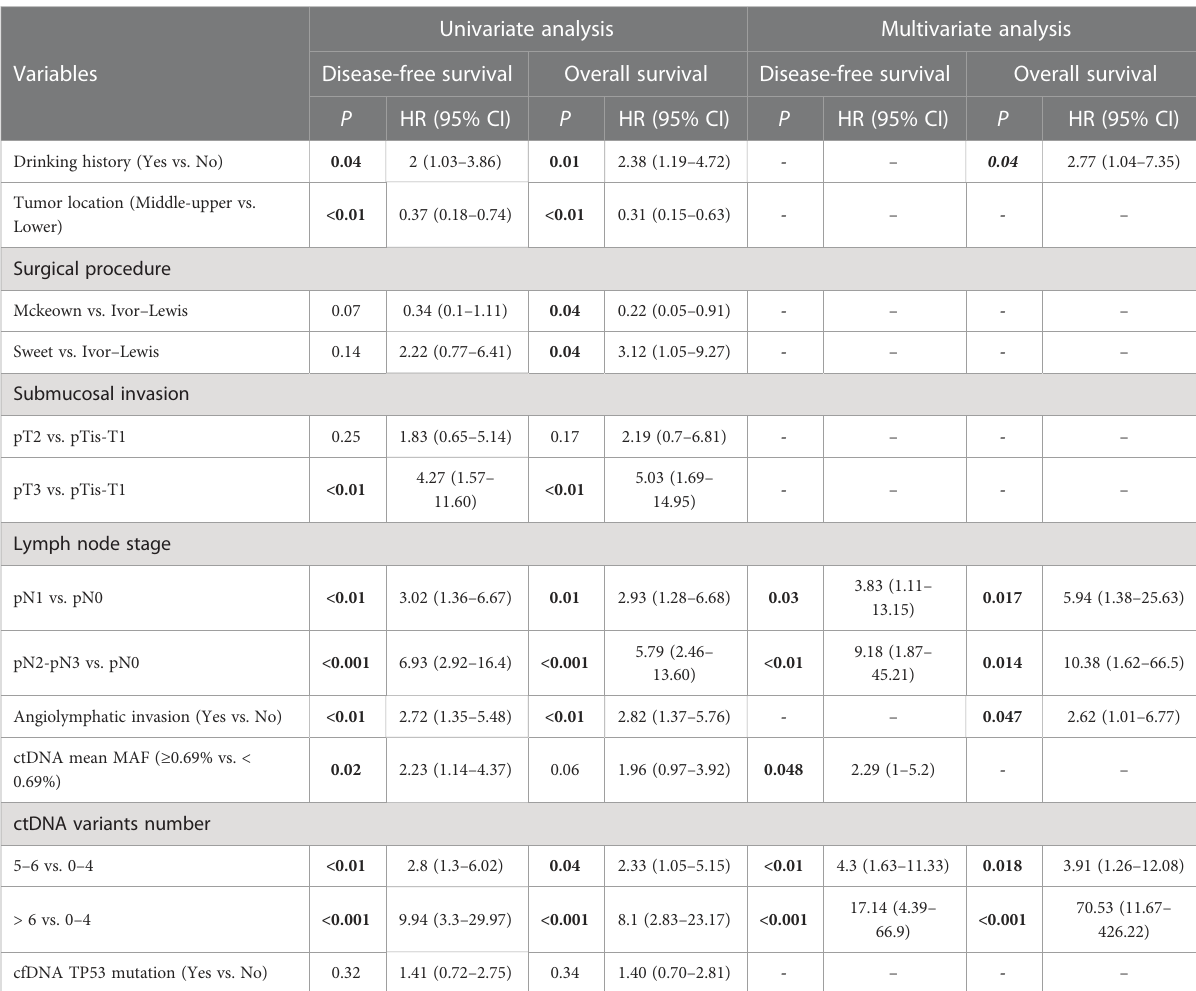
TABLE 2 Cox regression analysis of predictors for DFS and OS of ESCC